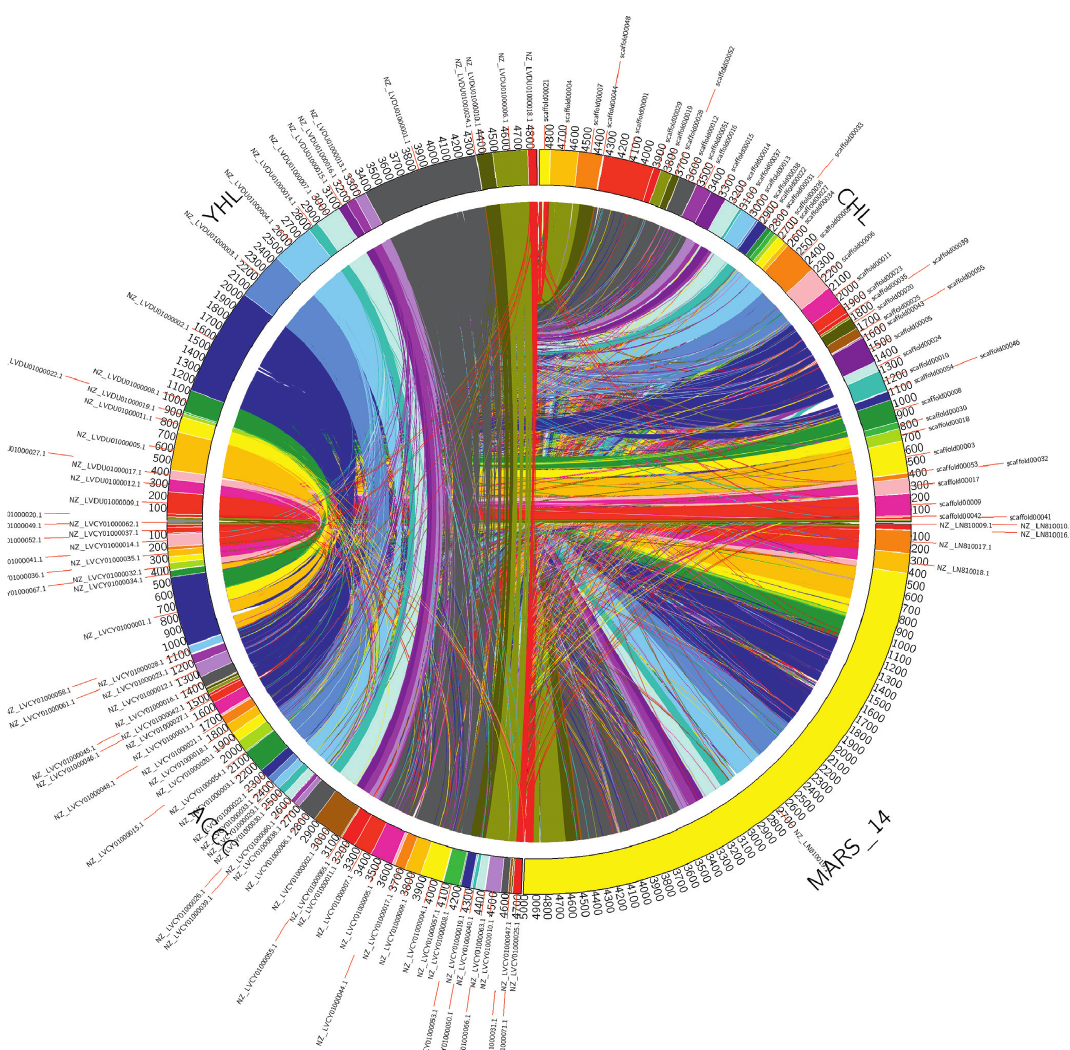
Figure 4: Genomes mapping between strains in the study. Each colored arc indicates an orthologous match between two species. The color segments inthe outer circle are randomlydisplayedand donot correspondtoa particularscheme. A minimumseed match size of500bpwas